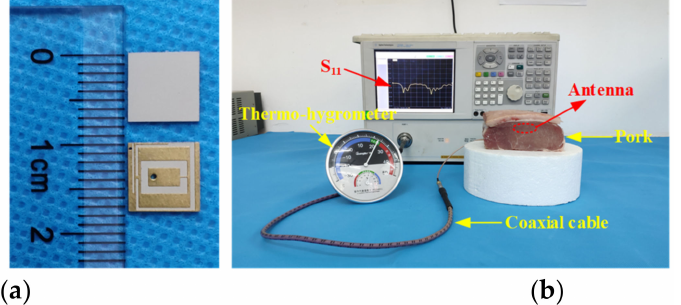
Figure 11. Measurement of the proposed antenna: ( a ) Fabricated antenna and ( b ) measurement setup. It can be seen from the measurement result in Figure 12 that the measured |S 11 | in the lower-frequency band was consistent with the simulated result, while the frequency offset in the upper frequency band was obvious. The reason for this may be that the gap between the radiation patch and the superstrate was generated unintentionally during the manual welding of the feed. This can be avoided by using precision processing equip- ment. Nevertheless, the measured |S 11 |of the proposed antenna can still cover the ISM bands of 902–928 MHz and 2.4–2.48 GHz. The measured relative bandwidths were 44.3% (0.72–1.13 GHz) and 33.0% (2.38–3.32 GHz) in the two frequency bands, respectively, both of which were close to the relative bandwidths in the simulation.